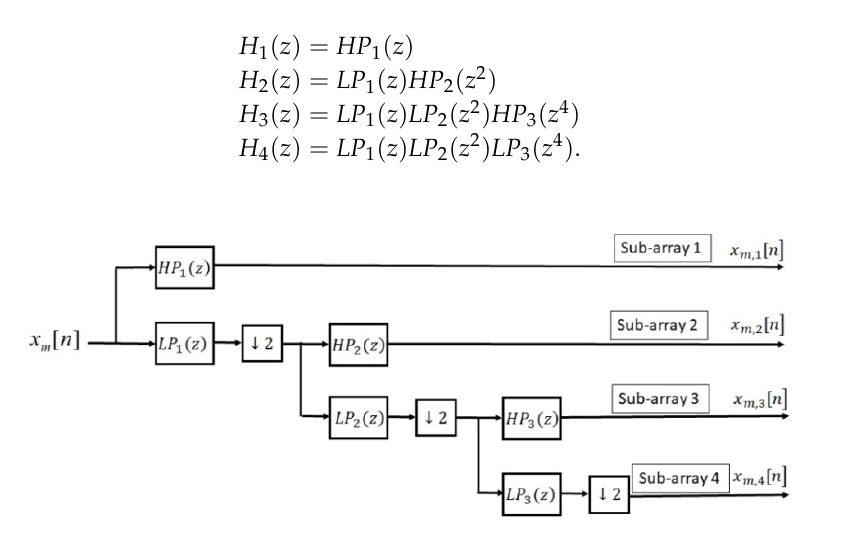
Figure 4. The multilevel tree structure to design the multirate analysis filter bank.